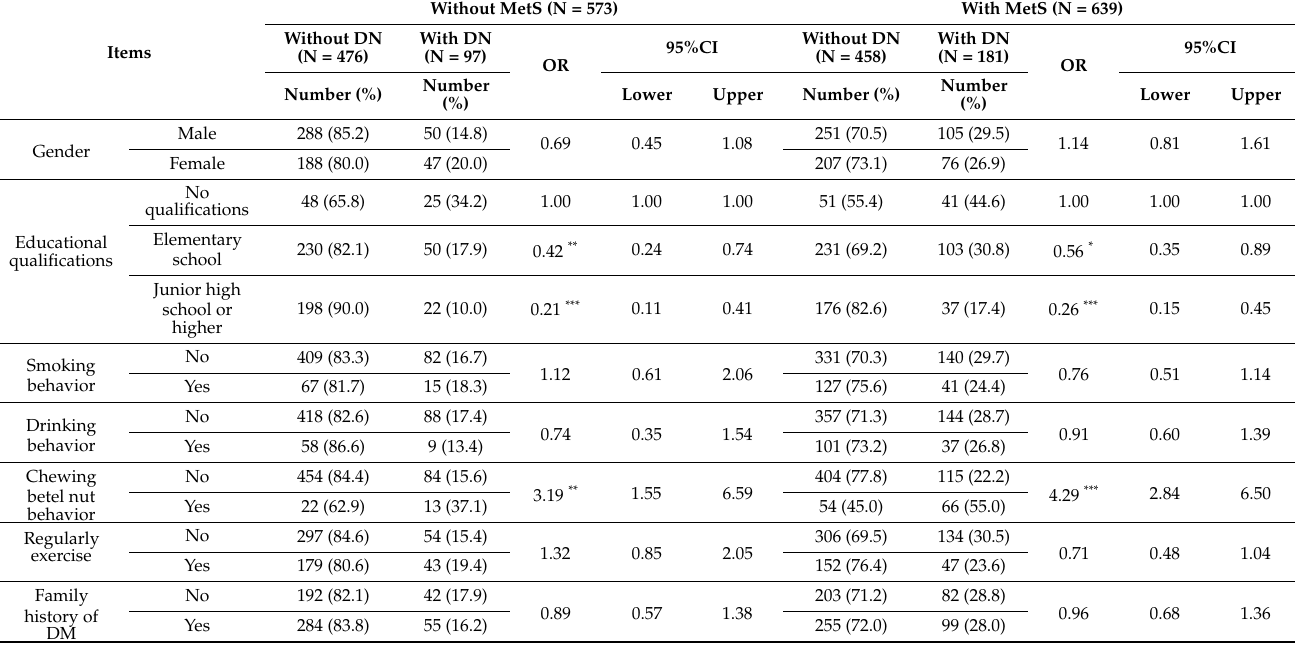
Table 2. Comparisons of categorical factors of DN between the patients with and without MetS (N =